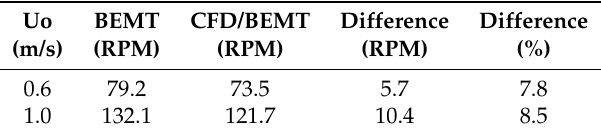
Table 3. Average turbine rotational speed.